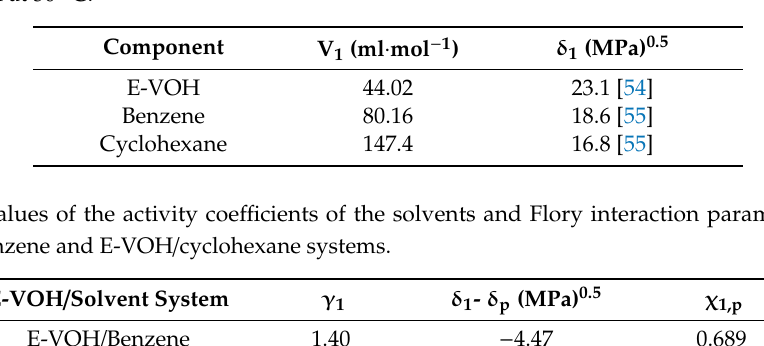
Table 3. Molar volume and Hansen solubility parameter of E-VOH, benzene, and cyclohexane determined at 30 ◦ C.